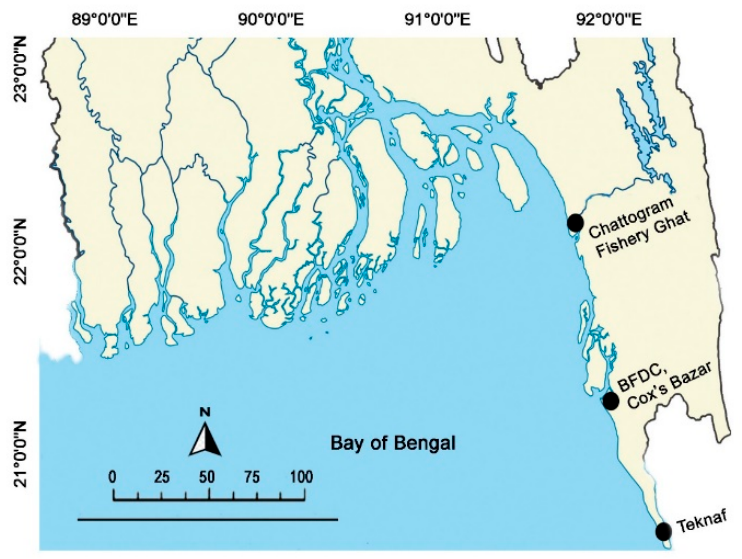
Figure 2. Map of the Bay of Bengal, Bangladesh. Black circles in the map indicate the sampling stations used in this study.